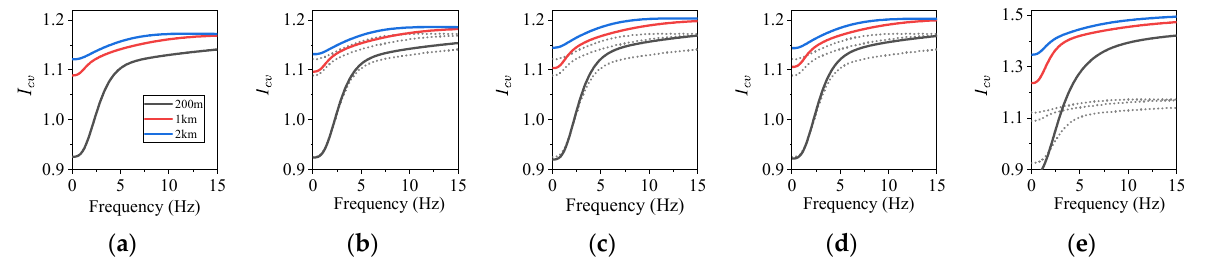
Figure 6. Adjustment coefficient for different loop configurations: ( a ) condition 1, ( b ) condition 2, ( c ) condition 3, ( d ) condition 4, and ( e ) condition 5.